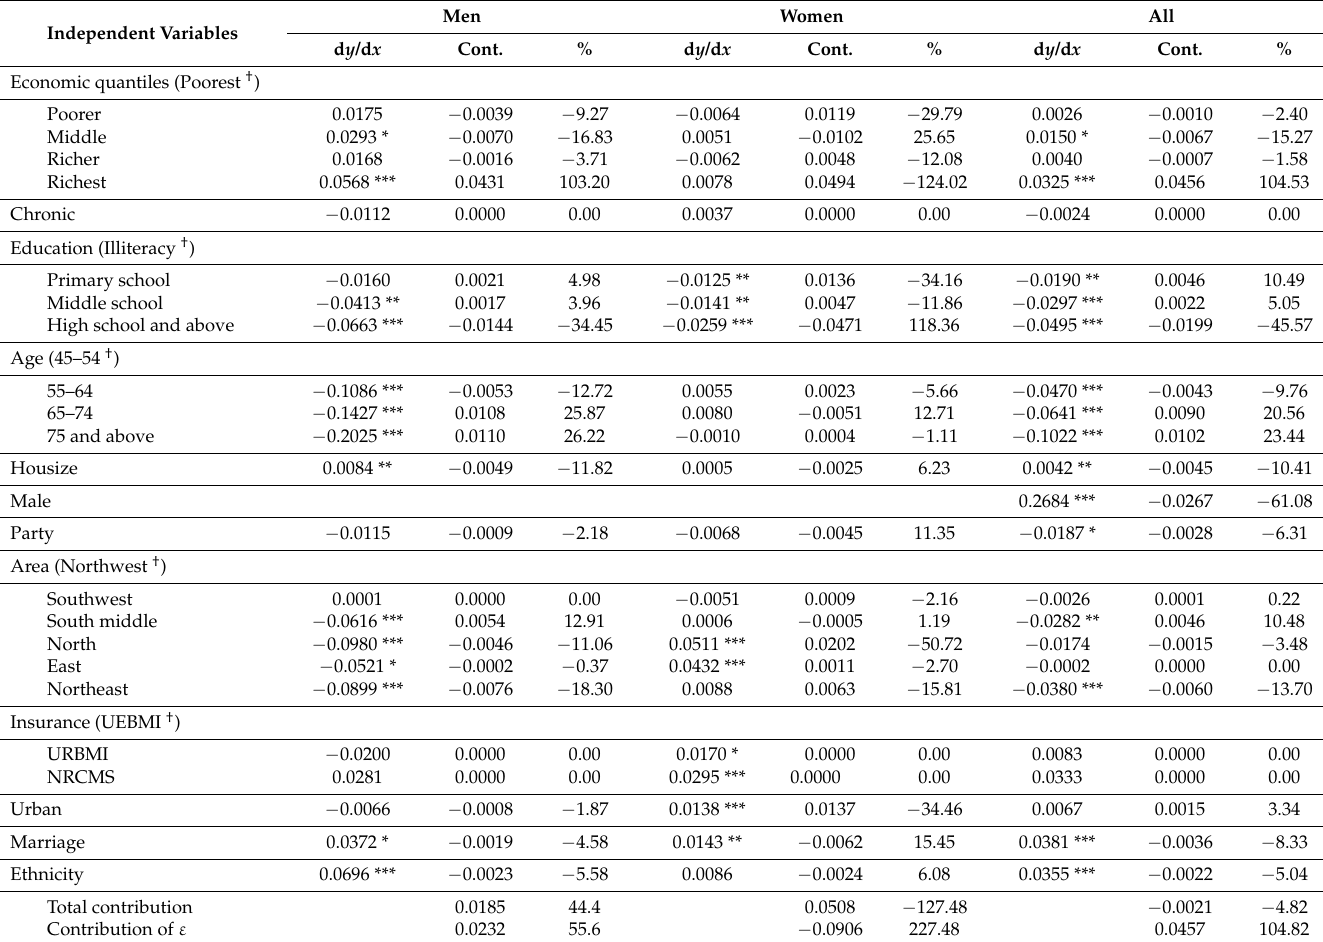
Table 4. Decomposition of concentration index of tobacco use prevalence